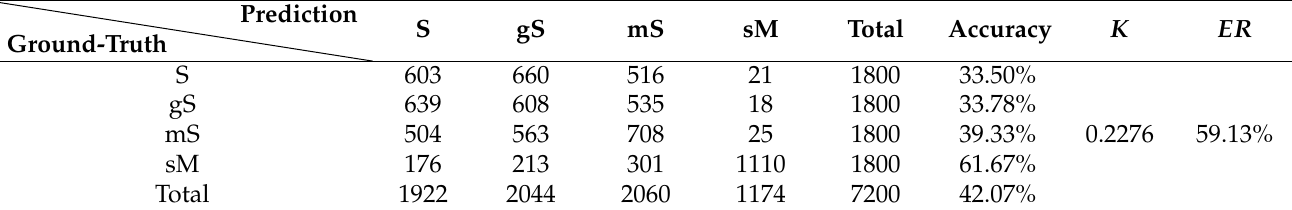
Table 5. Classification results of the Random Forest model using Local Binary Pattern. Ground-Truth